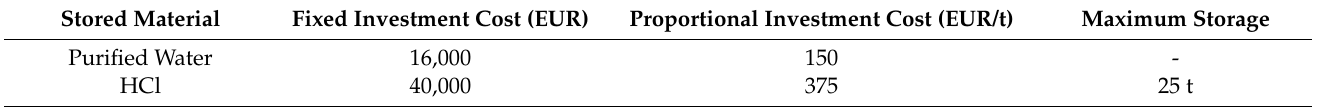
Table 3. Parameters of cost and maximum capacities for storage